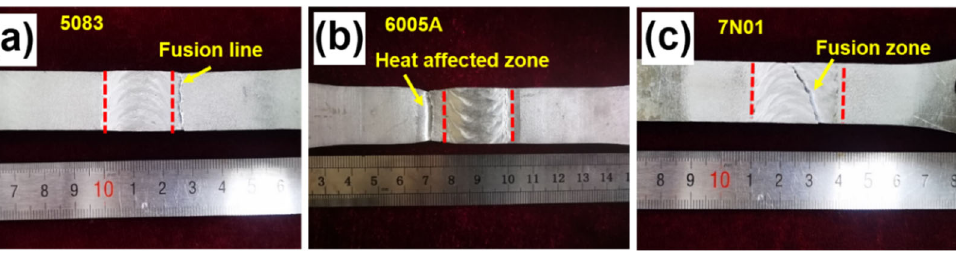
Figure 13. Fracture position of different aluminum alloy welded joints: ( a ) 5083; ( b ) 6005A; ( c ) 7N01.